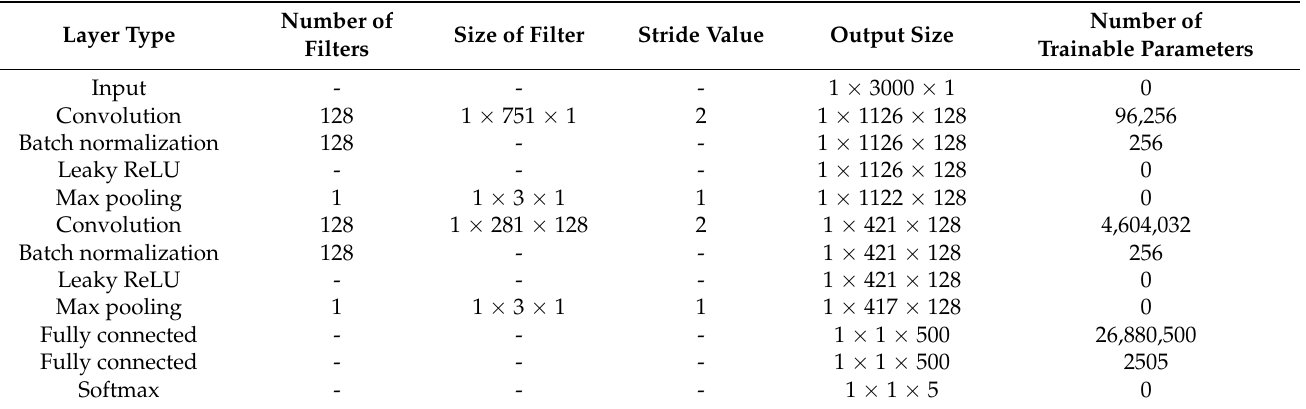
Table 4. Proposed DBFD model’s